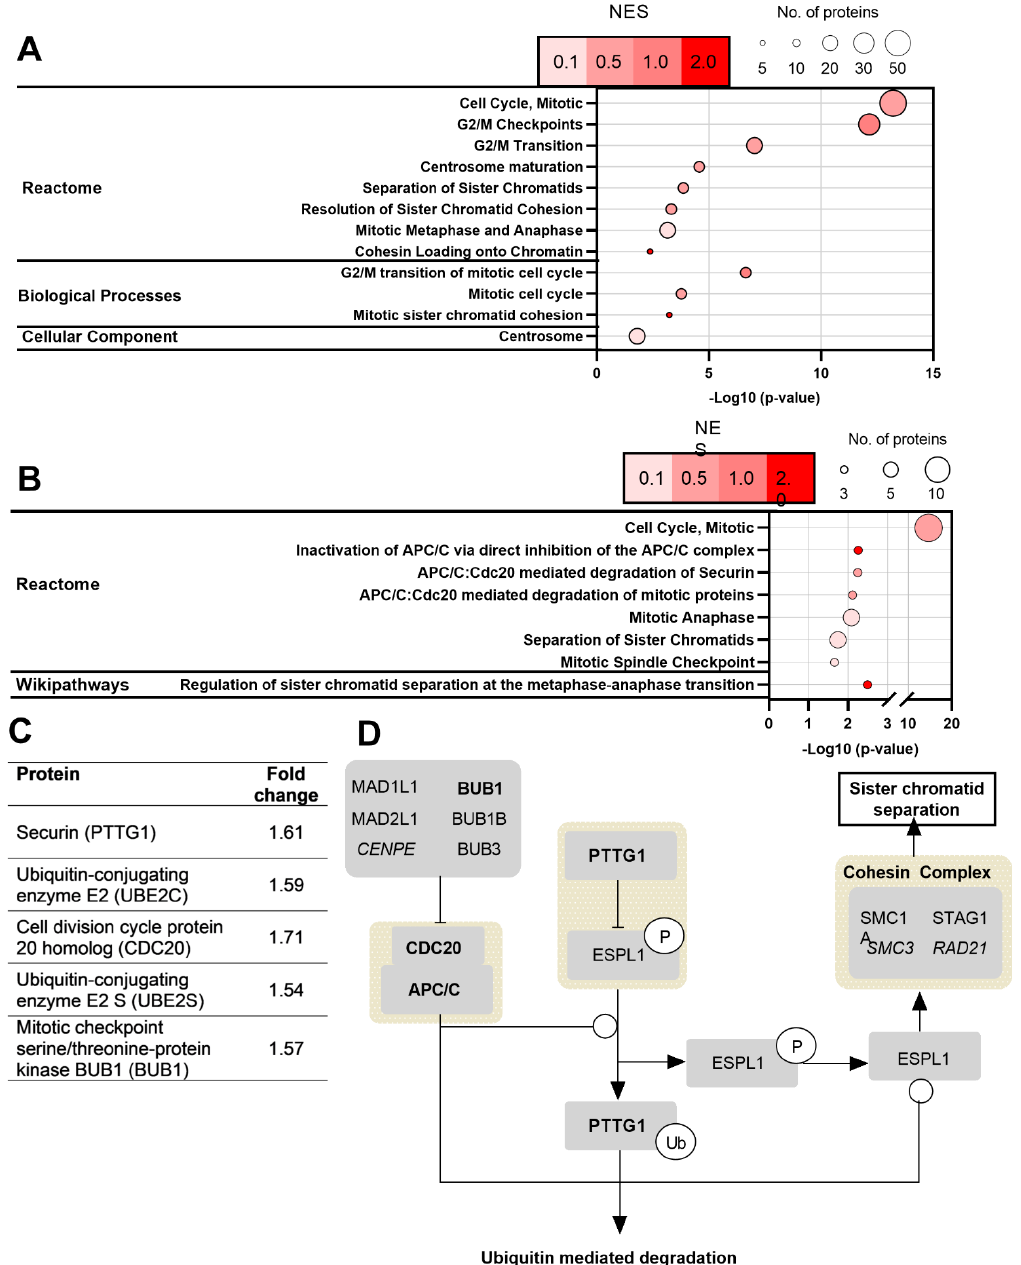
Figure 2. ( A ) Enrichment analysis of MGO-modified proteins using DAVID. Due to a large number of enriched terms, only those associated with mitosis were included and redundant terms were excluded. NES, normalised enrichment score. NES was calculated by dividing the fold enrichment by average enrichment of all terms; ( B ) enrichment analysis of upregulated proteins following MGO treatment (500 µ mol/L for 24 h). Due to a large number of enriched terms, only those associated with mitosis were included and redundant terms were excluded; ( C ) fold change in proteins of interest following MGO treatment; ( D ) diagram showing the regulation of sister chromatid separation. Proteins in bold show increased abundance by MGO. Proteins in italics contain one or more MGO